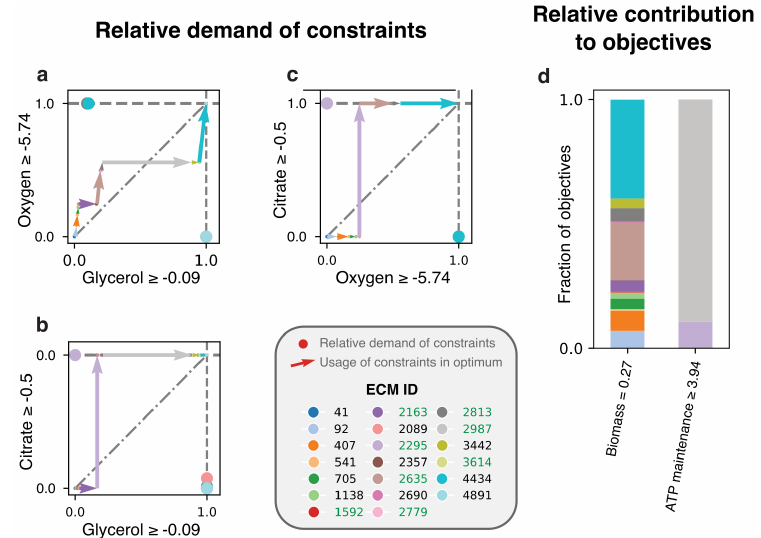
Figure 5. Lactobacillus plantarum produces ATP at lower carbon-yields to save oxygen for biomass production. The ECMs in the active subnetwork of the genome-scale L. plantarum model [19] were enumerated based on measured fluxes adapted from [38], and we focused on the costs of EMs for the uptake of oxygen, glycerol, and citrate. ( a – c ) The uptake rates of oxygen, glycerol, and citrate by each active EM are shown. To fully show the relation between the costs for these three constraints, we made a different plot for each pair. ( d ) The contribution of the EMs to the production of non-growth related ATP and to biomass production is shown. An ECM ID is written in green if the ECM produces lactate. All citrate and a large fraction of the glycerol is used by ECMs 2295 and 2987 to meet the ATP-maintenance demand. Still, this production is done without the use of oxygen and while producing lactate, even though producing ATP with oxygen and by producing acetate would have a higher carbon-yield. It thus seems that all oxygen is needed for biomass synthesis, and therefore ATP is produced via a carbon-inefficient